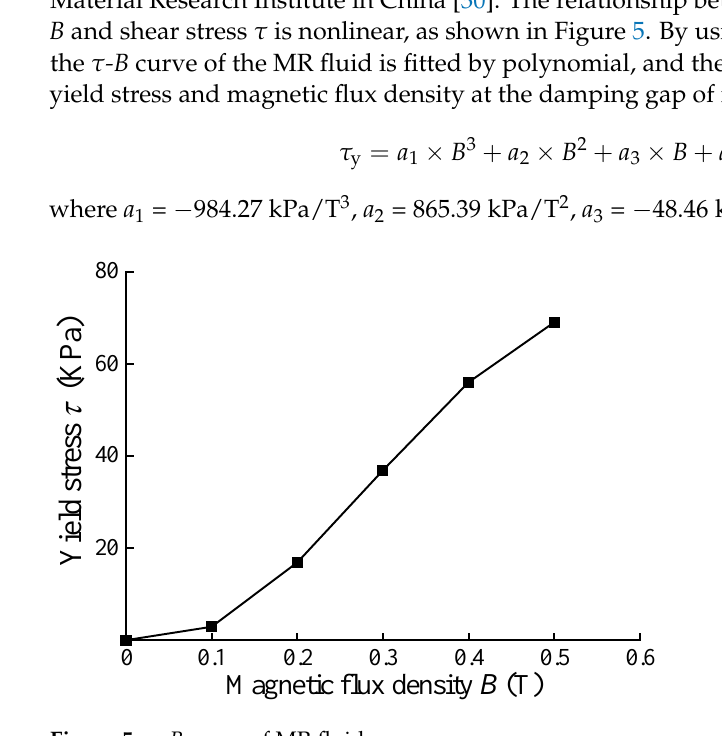
Magnetic field intensity H (kA/m) Figure 6. B - H curve of 10# steel. 3.2. Electromagnetic Field Simulation of MR Valve Considering the calculation scale and accuracy, the magnetic field simulation is an- alyzed by using the axisymmetric two-dimensional (2D) model. Neglecting the influence of the end cover, sealing ring and other structures on the magnetic field, adopting the top-down modeling method, the two dimensional simplified simulation geometry mod- el of the radial MR valve is shown in Figure 7. Choosing a level 1 SmartSize intelligent mesh division and a quadrilateral mesh structure element to apply a magnetic flux line parallel boundary without magnetic leakage, and current density is applied to the coil element to input the excitation load, the division of different colors represents the mate- rial with different attributes, the final finite element model is shown in Figure 8.